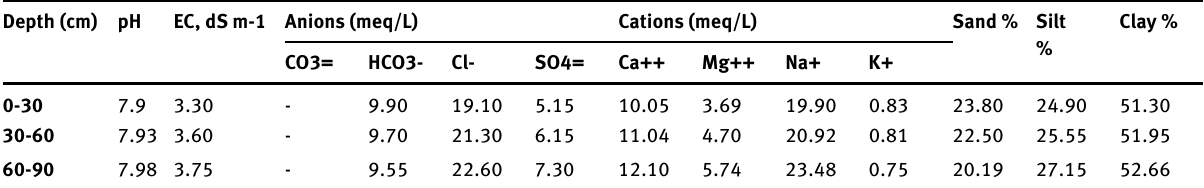
Table 4: Physical and chemical analysis of soil paste extract of the experimental site pre-sowing the cotton crop. Depth (cm) pH EC, dS m-1 Anions (meq/L) Cations (meq/L)